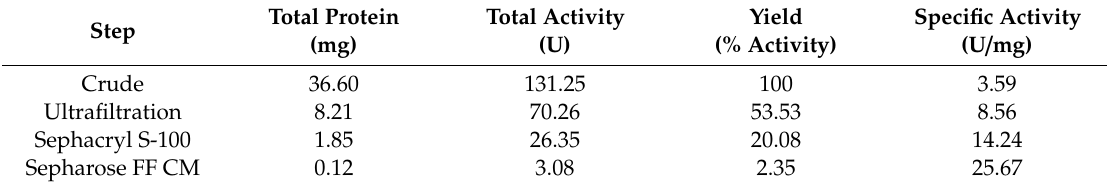
Table 1. Purification of polygalacturonase (PG) isozymes from a culture of Foc4.